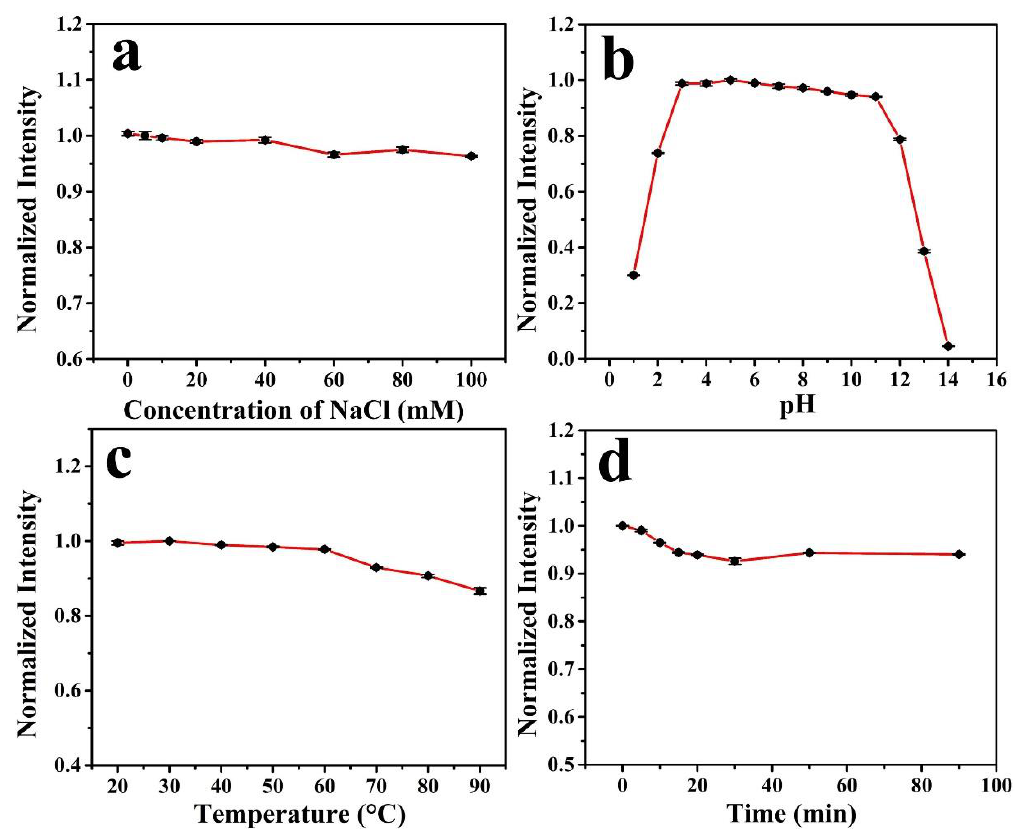
Figure 4. ( a ) The effect of various NaCl concentrations on the N, F-CDs fluorescence intensity. ( b ) The effect of pH on the fluorescence intensity of the N, F-CDs. ( c ) Normalized fluorescence intensity at different temperature. ( d ) Photostability of the N, F-CDs.